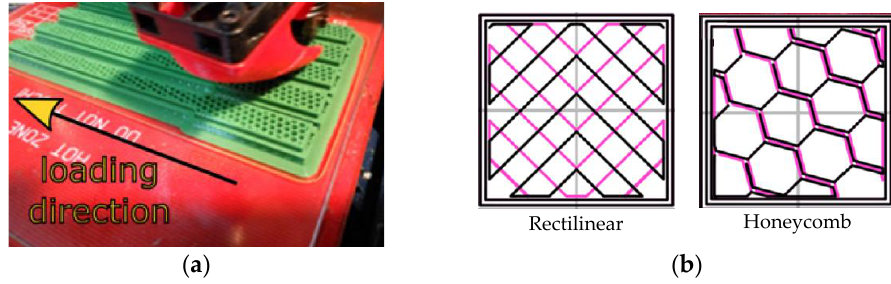
Figure 12. ( a ) Orientation of infill patterns with respect to the loading direction and ( b ) rectilinear and honeycomb infill patterns (Adapted with permission from [67]. Copyright 2018, Elsevier)